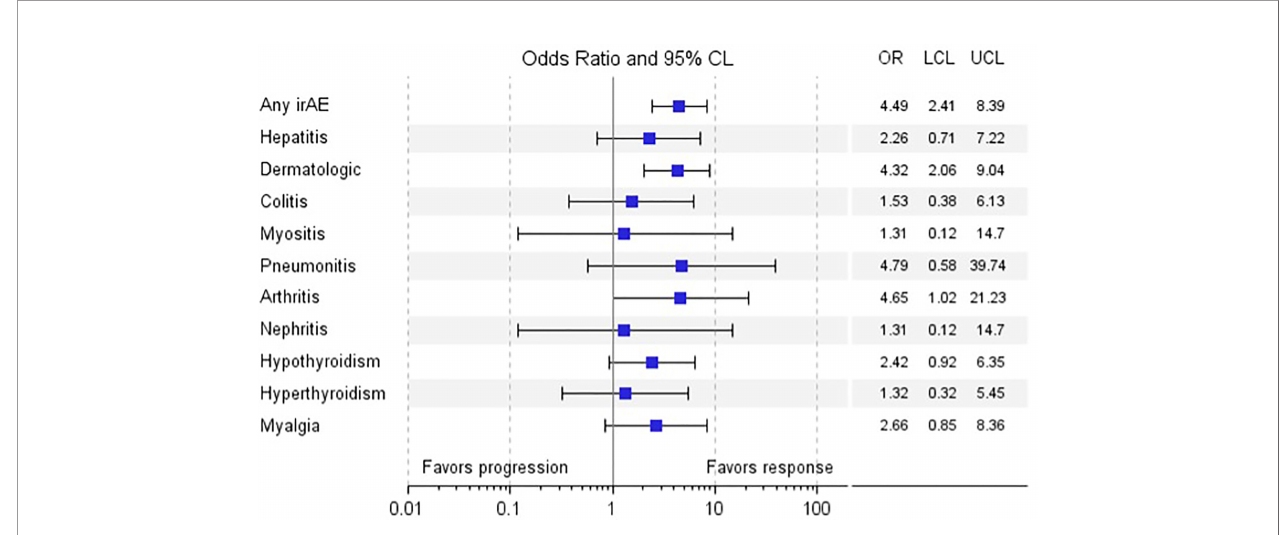
FIGURE 3 | Odds Ratio of Response vs . Non-response by irAE. a. Legend: Forest plot of odds ratio of response vs . non-response by various